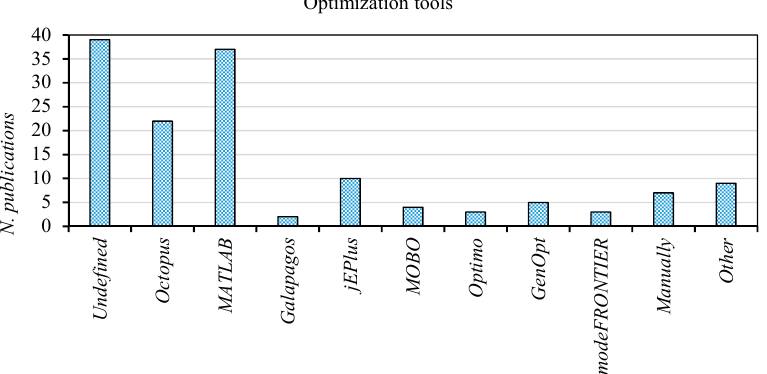
Figure 7. Number of publications for each optimization engine exploited in the MOO models. Table 3. Tabular review of journal articles about Python-based MOO workflows.